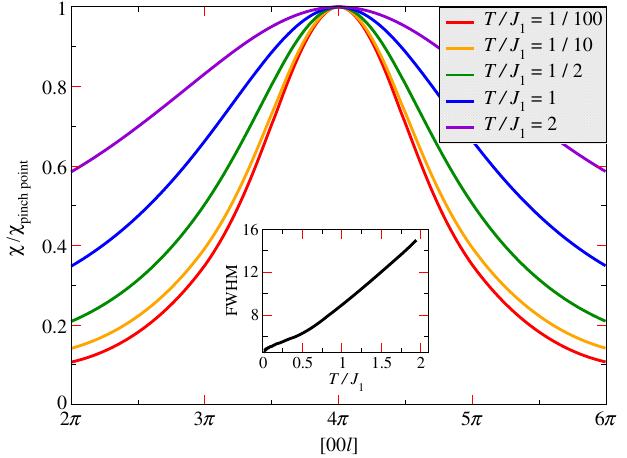
FIG. 8. The susceptibility of the S ¼ 1 = 2 isotropic nearest- neighbor Heisenberg antiferromagnet plotted along the 1D cut (see the white line in the T=J 1 ¼ 1 = 100 plot in Fig. 6) across the bow-tie width at different temperatures. The inset shows the FWHM of the curves as a function of the temperature.